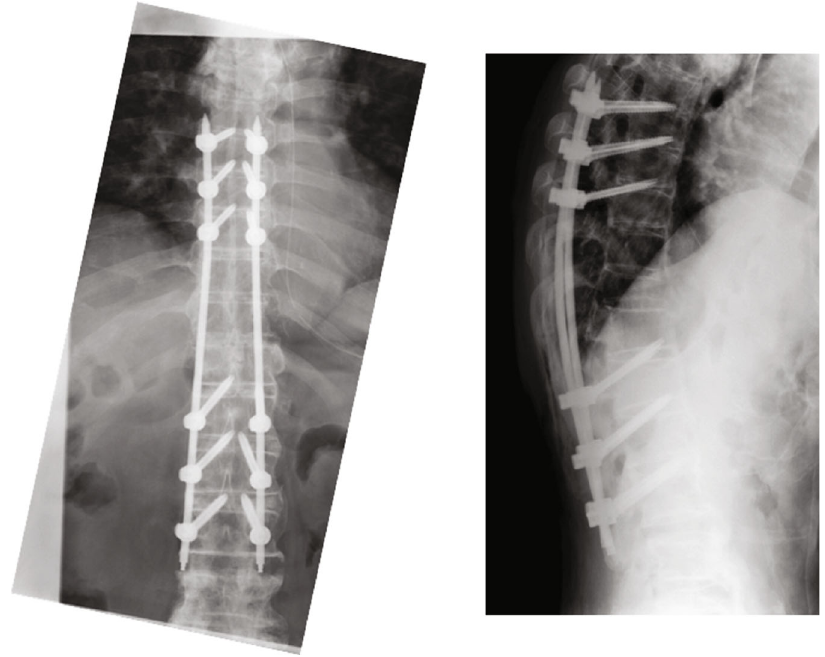
Figure 4: Percutaneous pedicle screw stabilization using penetrating endplate screw technique was performed 3 levels above and below the a ff ected vertebrae.